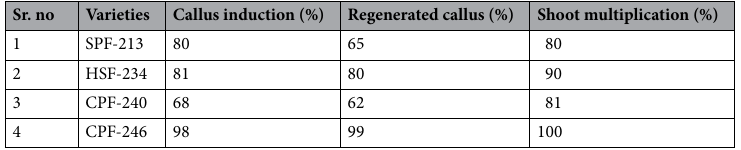
Table 1. Varietal responses of sugarcane cultivars for tissue